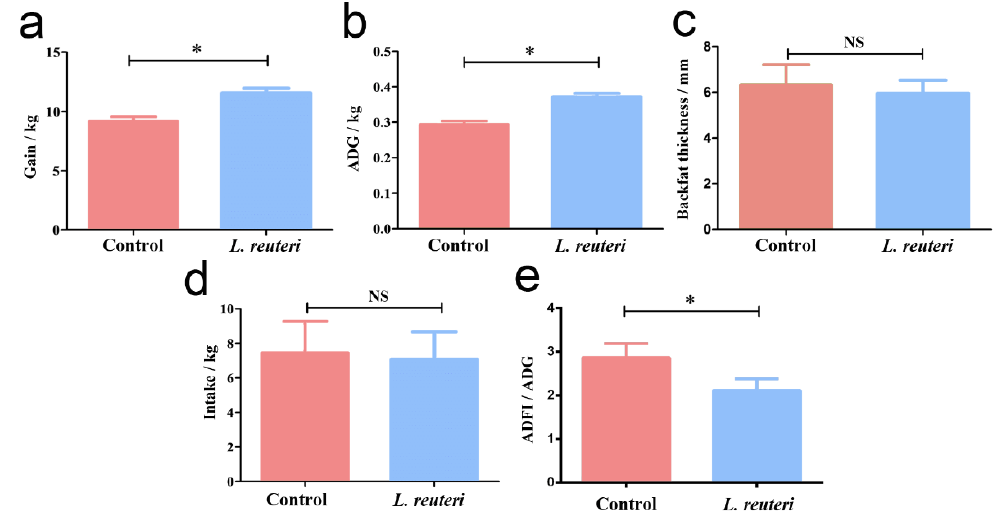
Figure 5. Feeding L. reuteri improved production performance of piglets. ( a ) Gain of piglets from original to the final. ( b ) Average daily gain of piglets. ( c ) The backfat thickness of piglets ( d ) Intake of piglets. ( e ) The intake to gain ratio, * p < 0.05 significant differences between treatments. NS, not significance differences ( p > 0.05).